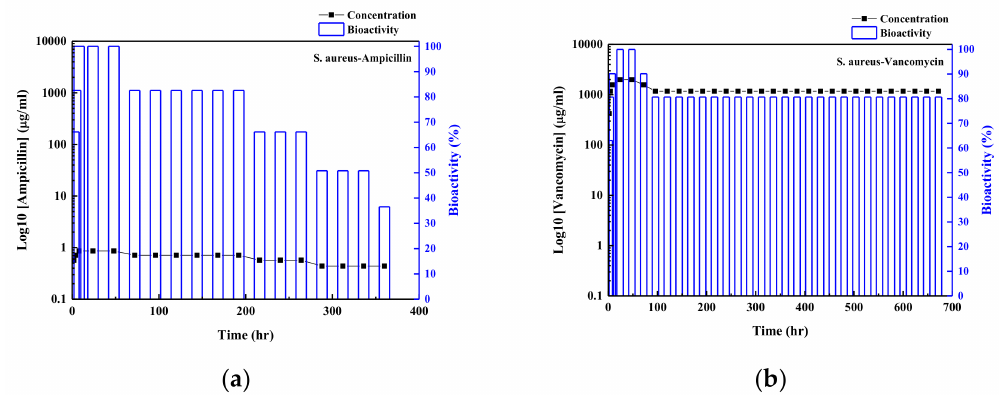
Figure 6. Bioactivities for S. aureus using the release of ( a ) ampicillin (sample (C)) and ( b ) vancomycin (sample (F)) from the antibiotic agent / ZnO nanorod arrays samples,